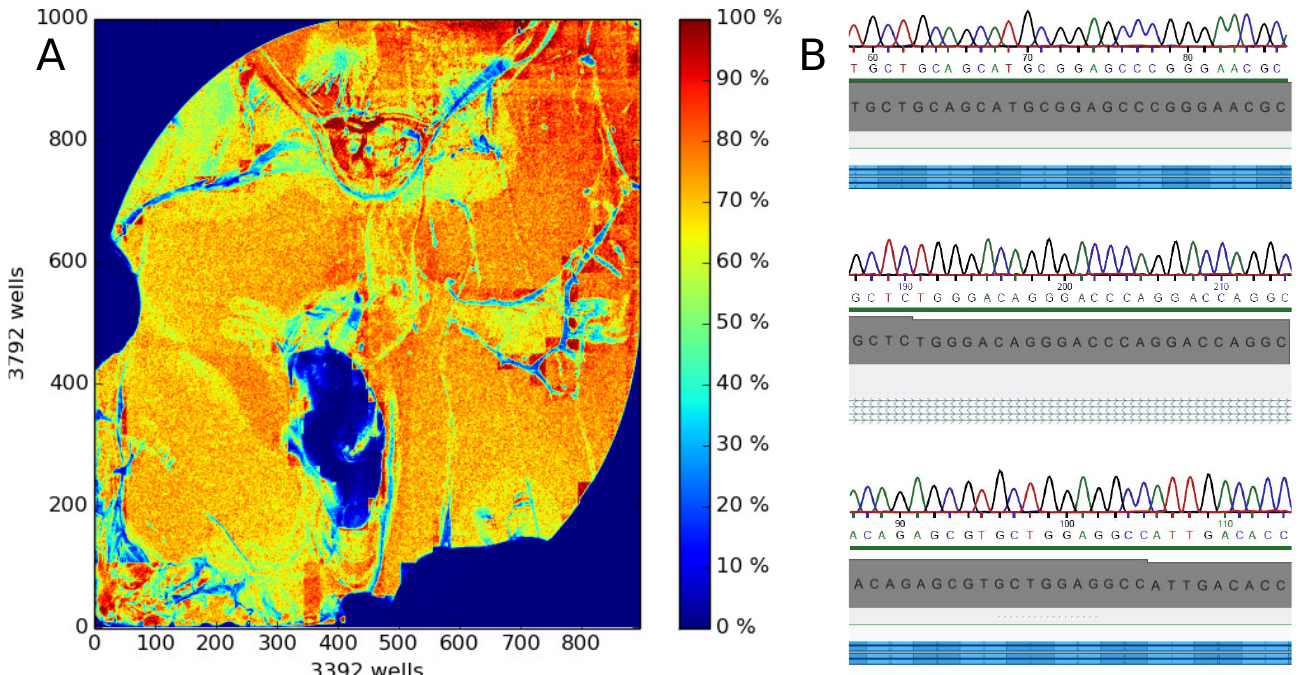
Figure 2. . Figure 2. Technical detail of assay establishment and validation. ( A ): Pseudo-color image of the Ion 318TM v2 Chip plate showing percent loading across the physical surface. This sequencing run had a 76% loading, which ensures a high Ion Sphere Particles (ISP) density. Every 318 chip contains 11 million wells and the color scale on the right side conduces as a loading indicator. Deep red coloration stays for a 100% loading, which means that every well in this area contains an ISP (templated and non-templated) whereas deep blue coloration implies that the wells in this area are empty. ( B ): Alignment of segments of the ion torrent sequence of the COMT gene as Golden Helix Genome Browse ® readouts versus the same sequence according to an externally predicted Sanger electropherogram. The figure has been created using the original outputs of the Ion PGM System (Life Technologies, Darmstadt, Germany) and the Golden Helix Genome Browse ® software (Version 2.0.4, Golden Helix, Bozeman, MT,